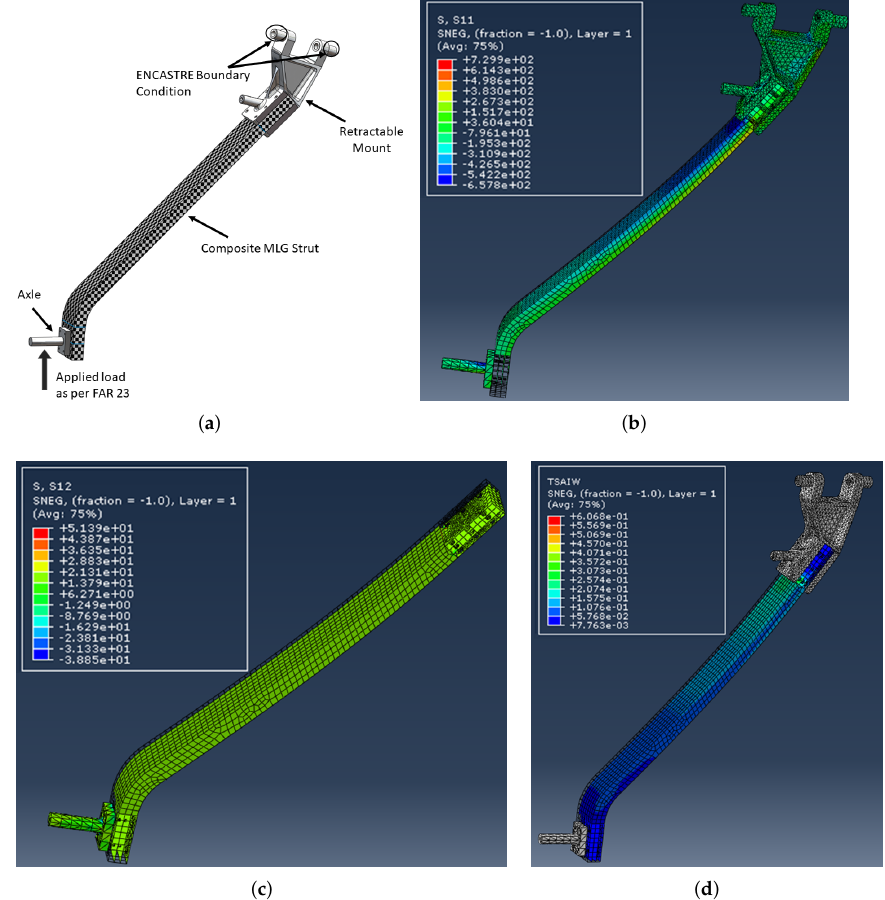
Figure 2. Design of the main landing gear strut and results of computational analysis under one- point landing condition: ( a ) Design of main landing gear assembly and applied boundary conditions. ( b ) Determination of maximum bending stress. ( c ) Determination of maximum shear stress. ( d ) Qual- ification of landing gear strut according to Tsai-Wu failure